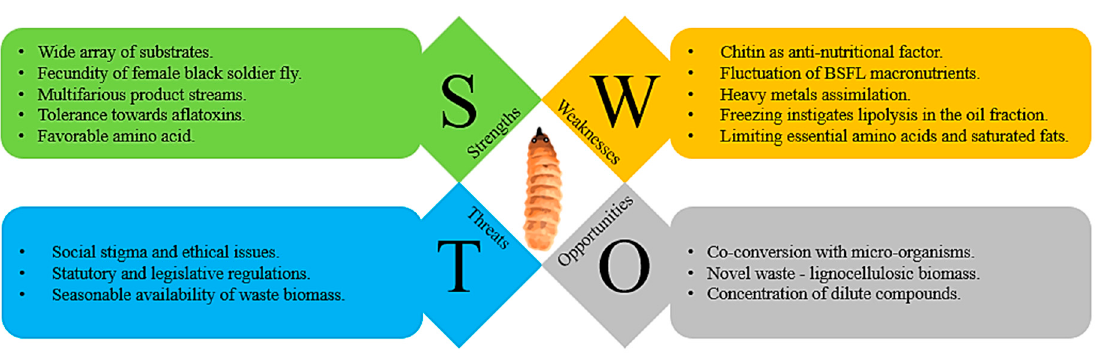
Figure 13. Strengths, weaknesses, opportunities, and threats (SWOT) analysis of BSFL rearing and processing.